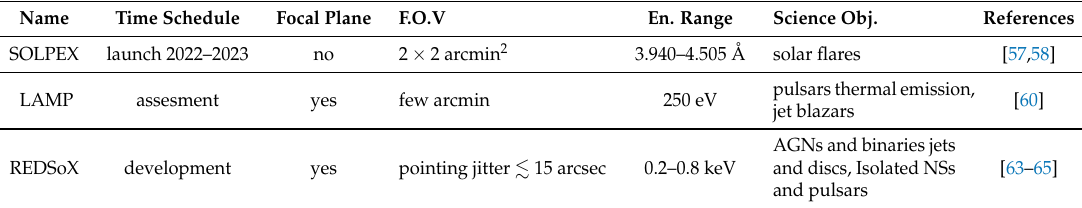
Table 2. Bragg diffraction polarimeter experiments and missions planned.